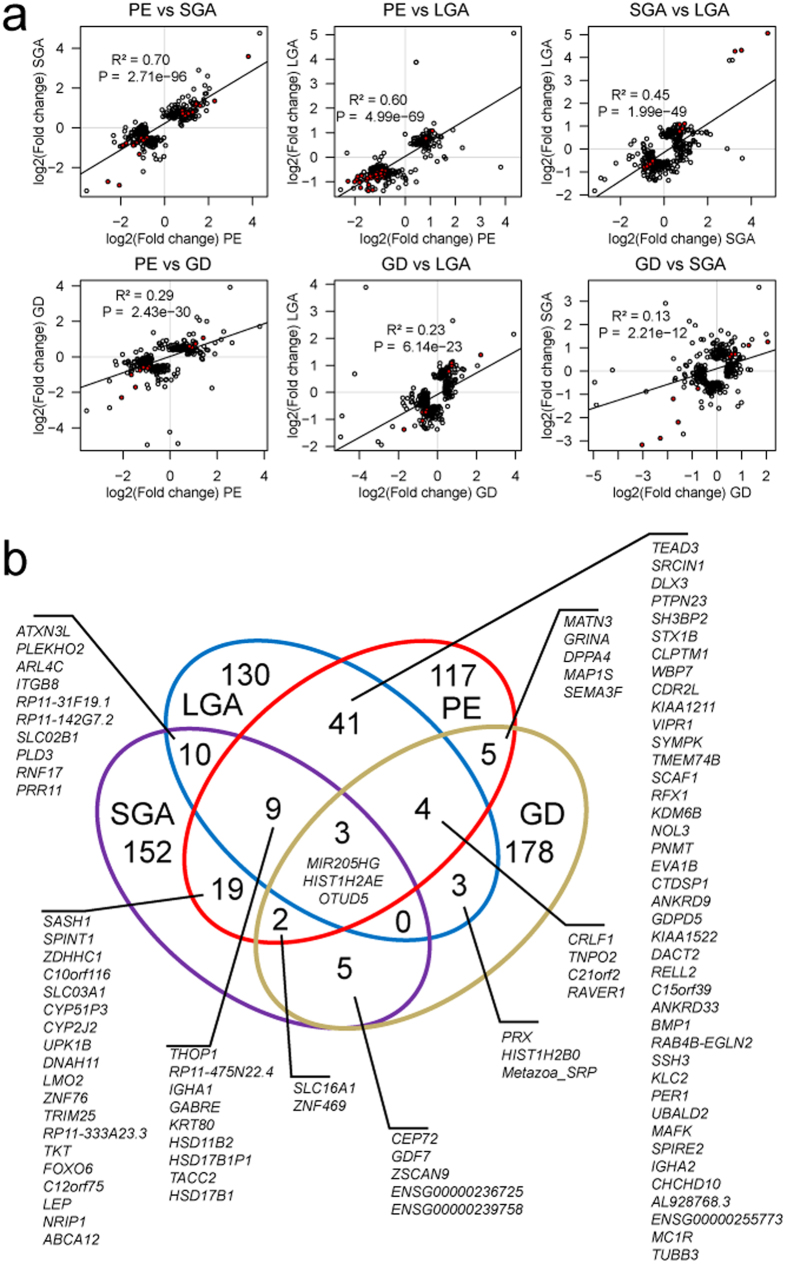
High concordance in placental gene expression changes in alternative scenarios of complicated compared to normal pregnancy.(a) Correlation plots for the fold changes of the highest ranked genes in the differential expression testing in each pregnancy complication compared to normal pregnancy (DESeq analysis). For each pairwise analysis of gestational complications, the lists of top-200 genes (circles) were united and plotted at the x,y-plane, where the axes correspond to the log2(fold changes) in the two groups. Red circles represent genes, which are shared between the top gene lists. The linear regression line along with correlation coefficient R2 and statistical significance is given. (b) Venn diagram for the shared fraction of the highest ranked genes in differential expression testing in alternative pregnancy complications. The number and gene list in each intersection are given. PE, preeclampsia, GD, gestational diabetes, SGA and LGA, small- and large-for-gestational-age newborns.